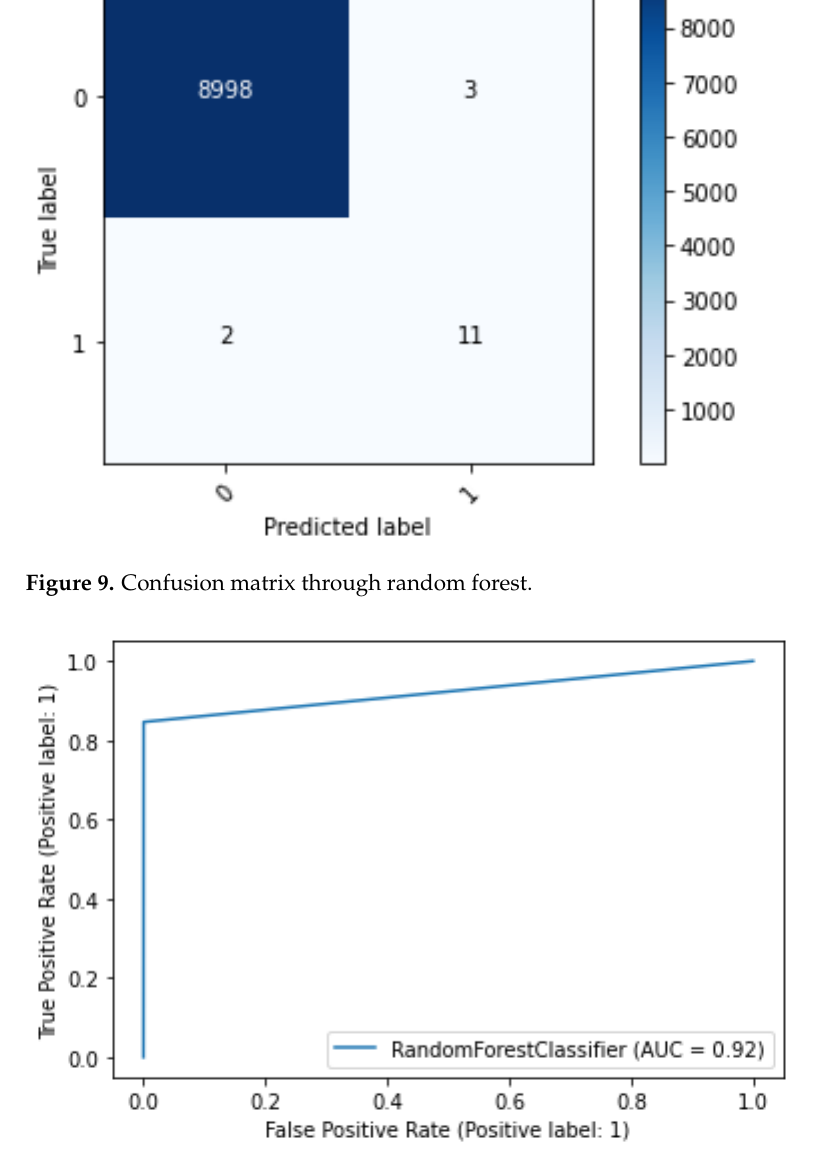
Figure 10. Accuracy of random